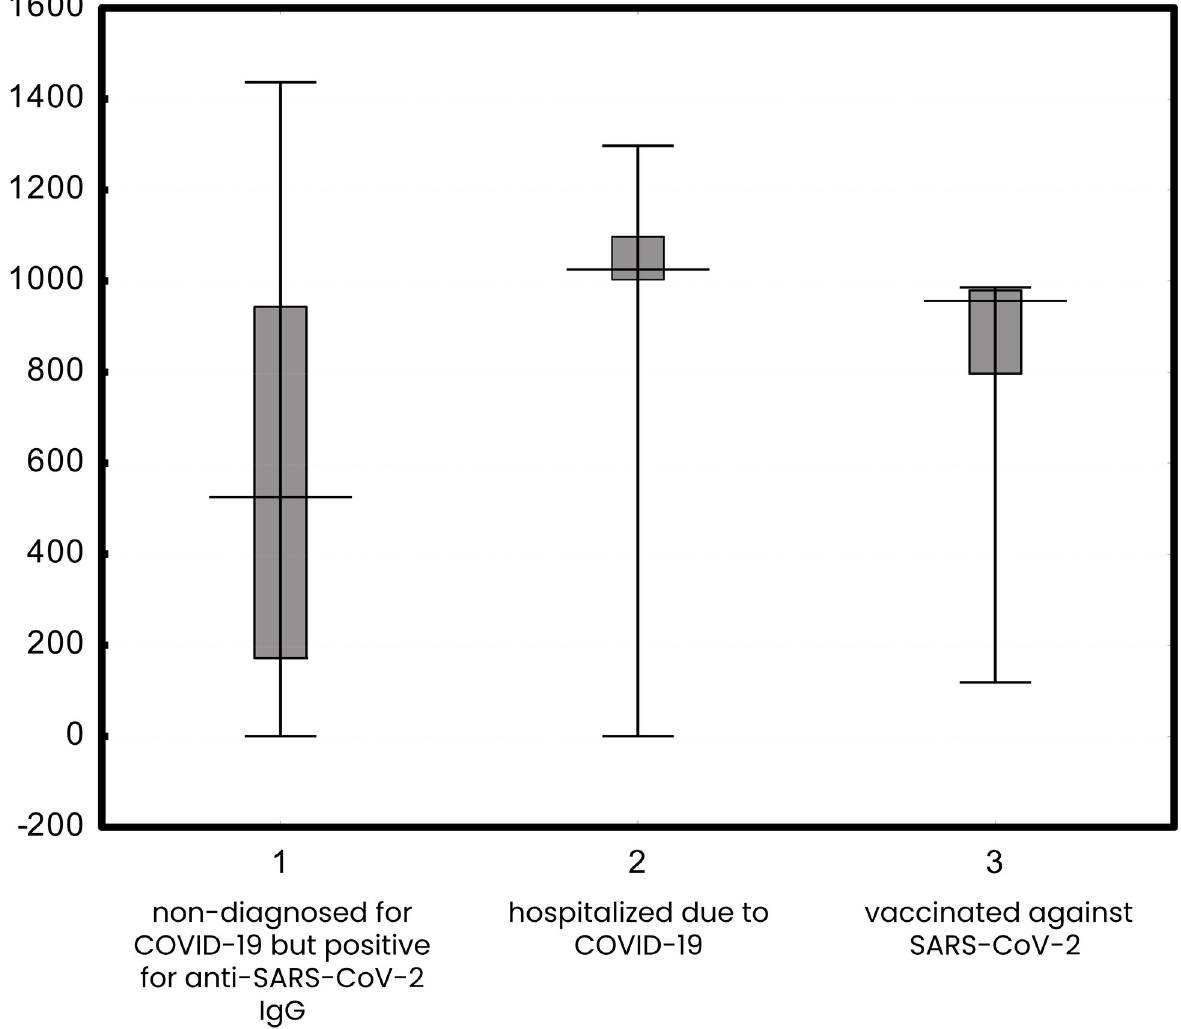
Fig 4. IgG specific to SARS-CoV-2 RBD in (1) non-diagnosed for COVID-19 but positive for anti-SARS-CoV-2 IgG, (2) in patients hospitalized due to COVID-19, (3) and in vaccinated against